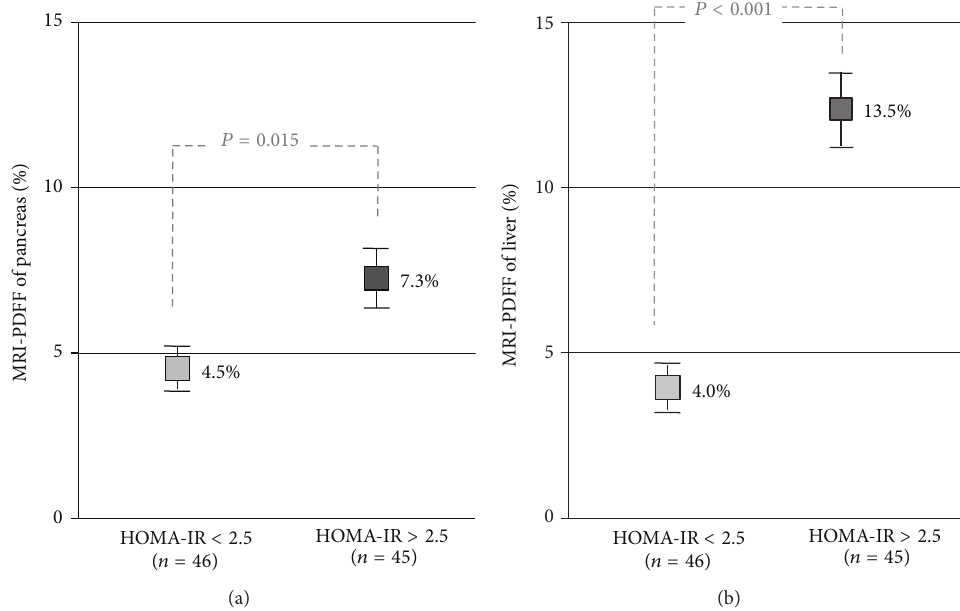
Figure 3: MRI-estimated pancreatic and liver fat content versus insulin resistance. Mean magnetic resonance imaging (MRI) proton-density- fat-fraction (PDFF) of pancreas and liver is shown for all patients in control and NAFLD groups. Participants with homeostatic-model-of- insulin-resistance (HOMA-IR) score less than the median value of 2.5 compared to participants with HOMA-IR greater than 2.5. 𝑃 -value determined using a two-tailed 𝑡